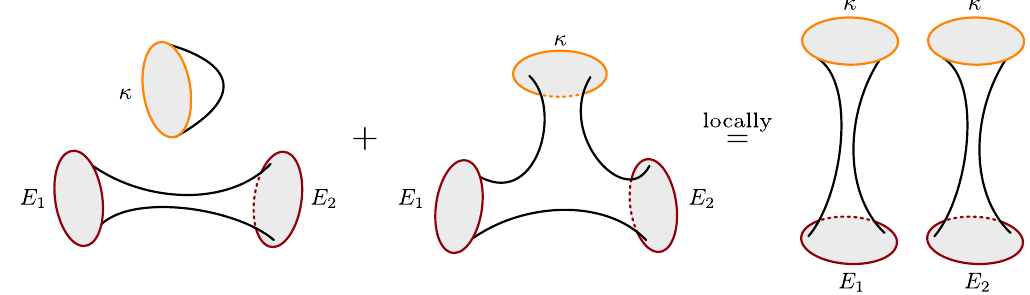
Figure 12: The geometries contributing to the spectral correlation (132), the genus expansion is suppressed for presentation purposes. Fixed energy boundaries are red and eigenbrane boundaries are orange. The first two terms should be normalized by one eigenbrane disk (labelled by κ ), the third term is normalized by two such disks. Here we again emphasize that the relation between these geometries holds